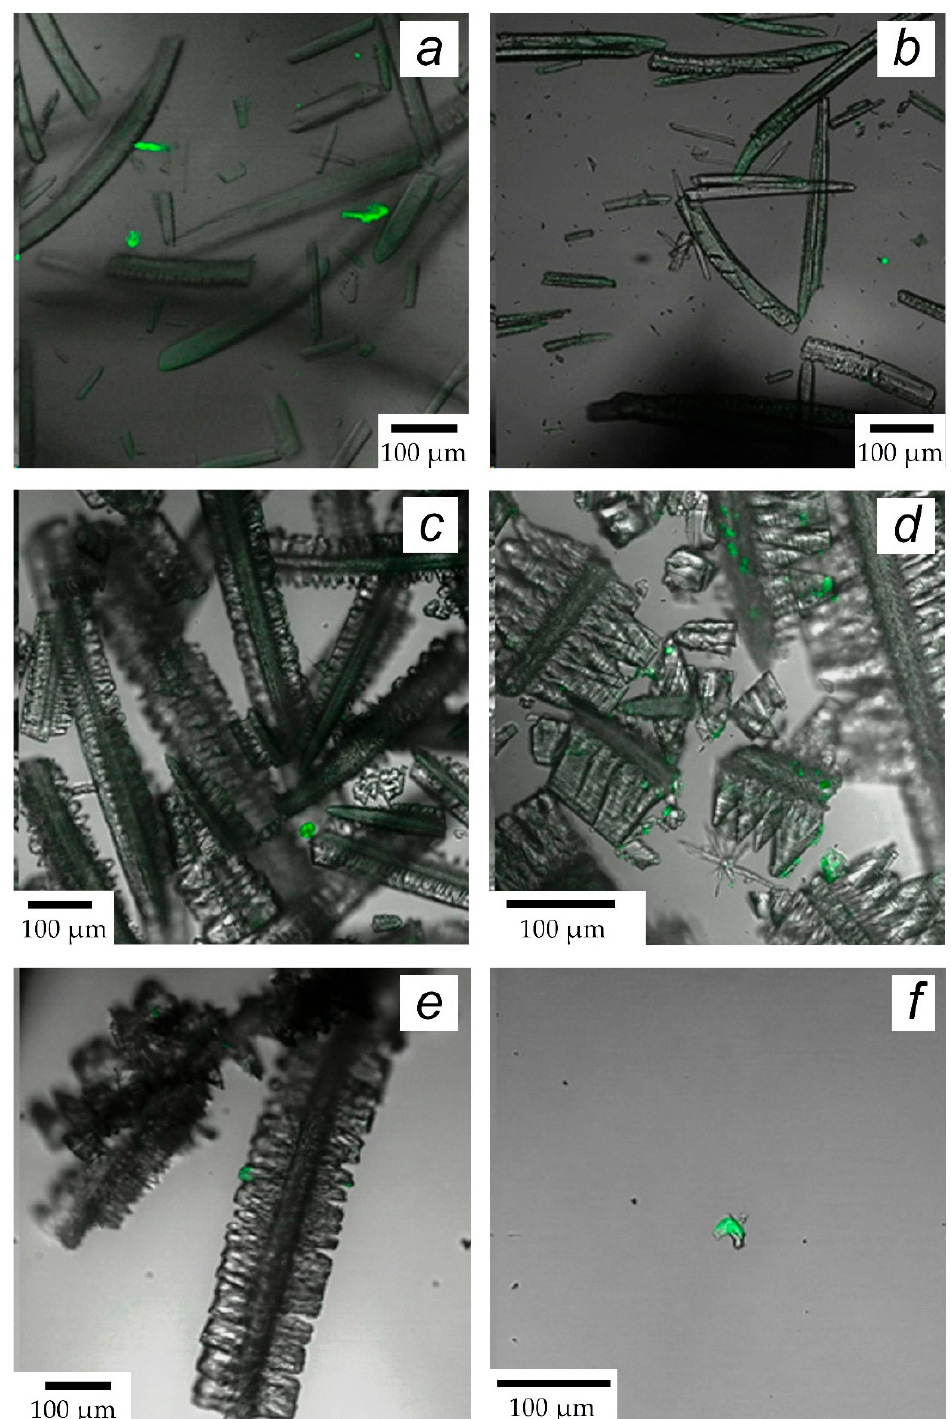
Figure 4. Two-dimensional images of calcium sulfate crystals in equilibrium with mother liquor in the presence 10 mg·dm − 3 of PAA-F1 in Ia ( a , b ), IIa ( c ), IIIa ( d ), Va ( e ) and Va ( f ) samples. The green color indicates location of PAA-F1.